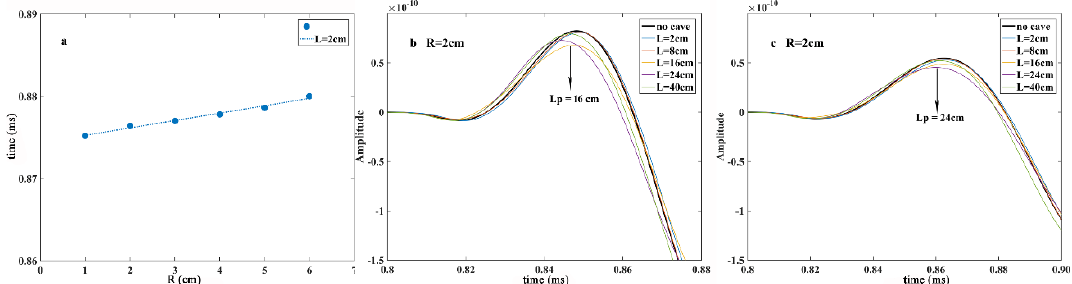
Figure 7. Effect of cave and excitation frequency on the P-wave. ( a , b ) Excitation frequency is 10 kHz. ( c ) Excitation frequency is 7 kHz. R represents the radius of the cave. L represents the distance of the cave to the borehole wall. P-wave recorded by the receiver is 0.4 m above the cave.